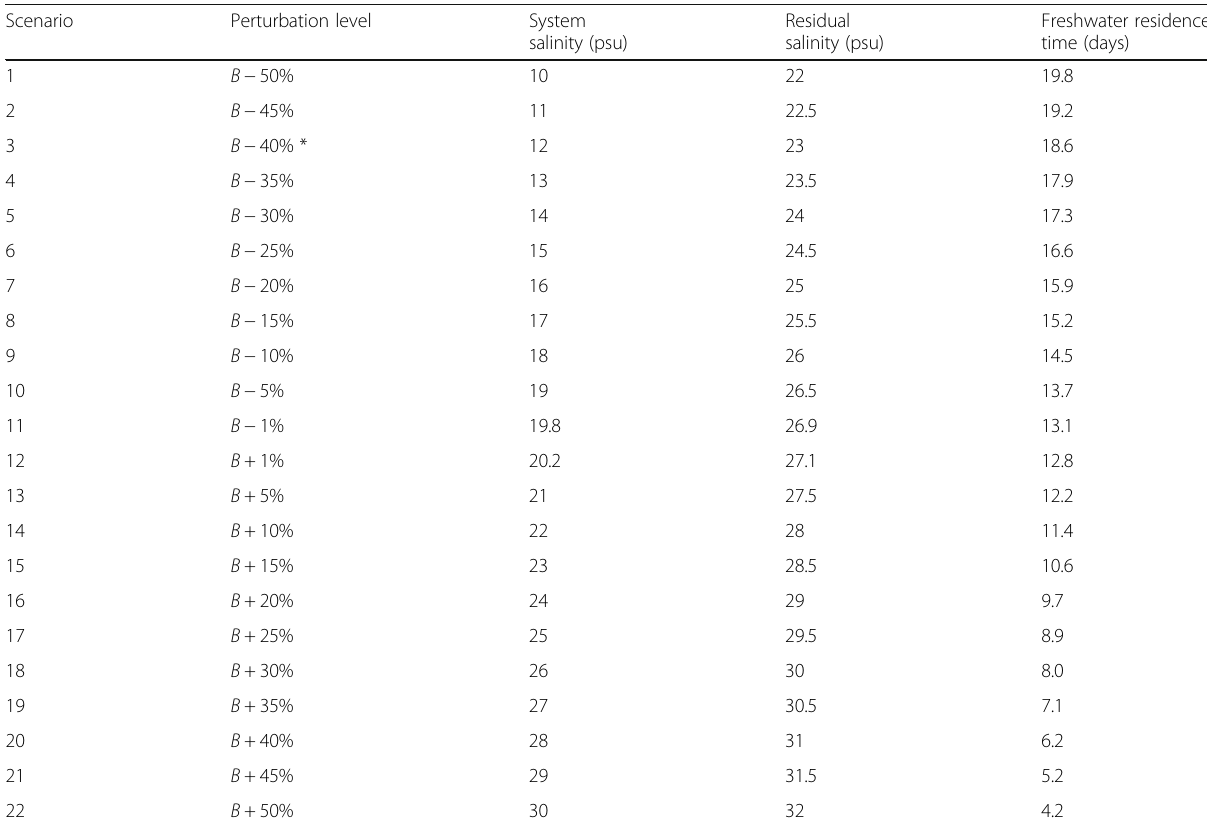
Table 2 The different model scenarios simulated for the desalination extents ranging between ± 1 and 50% from the baseline values ( ‘ B ’ ) for Pulicat lagoon. * represents the simulated scenario that is closest to the real-time